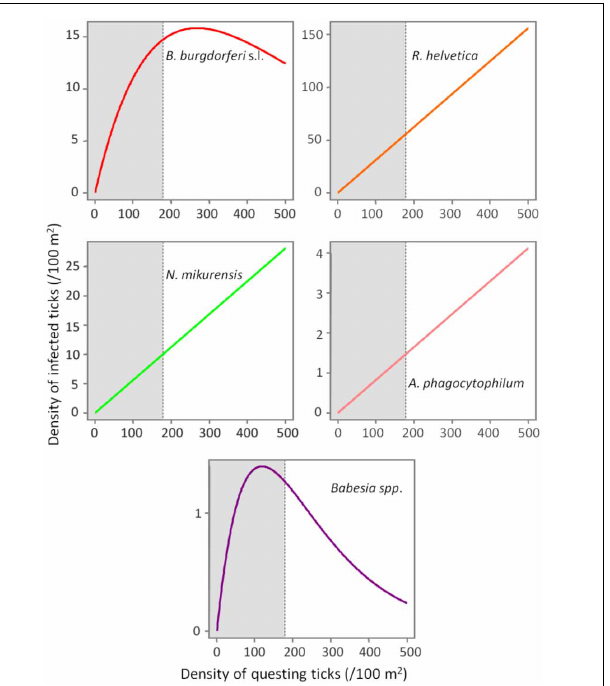
FIGURE 3 | Density and prevalence relations. Significant negative correlations between the density of questing ticks and the infection prevalence were found for B. burgdorferi s.l. ( p = 3 . 6 × 10 − 10 ) and Babesia spp. ( p = 4 . 9 × 10 − 5 ). On the other hand, there was no correlation found between these variables for R. helvetica ( p = 1 . 0), N. mikurensis ( p = 1 . 0), and A. phagocytophilum ( p = 0 . 69). Note that due to the very small exponents, the curves look approximately linear, although they are in fact exponential, as explained in the text. The data set included all of the areas except for Duin&Kruidberg.